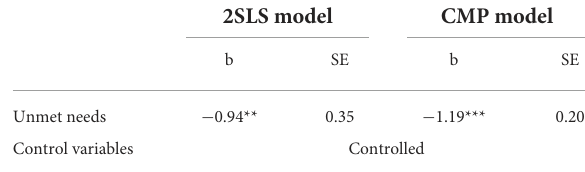
TABLE 5 Robust test of ordered logit regression analysis results ( N =